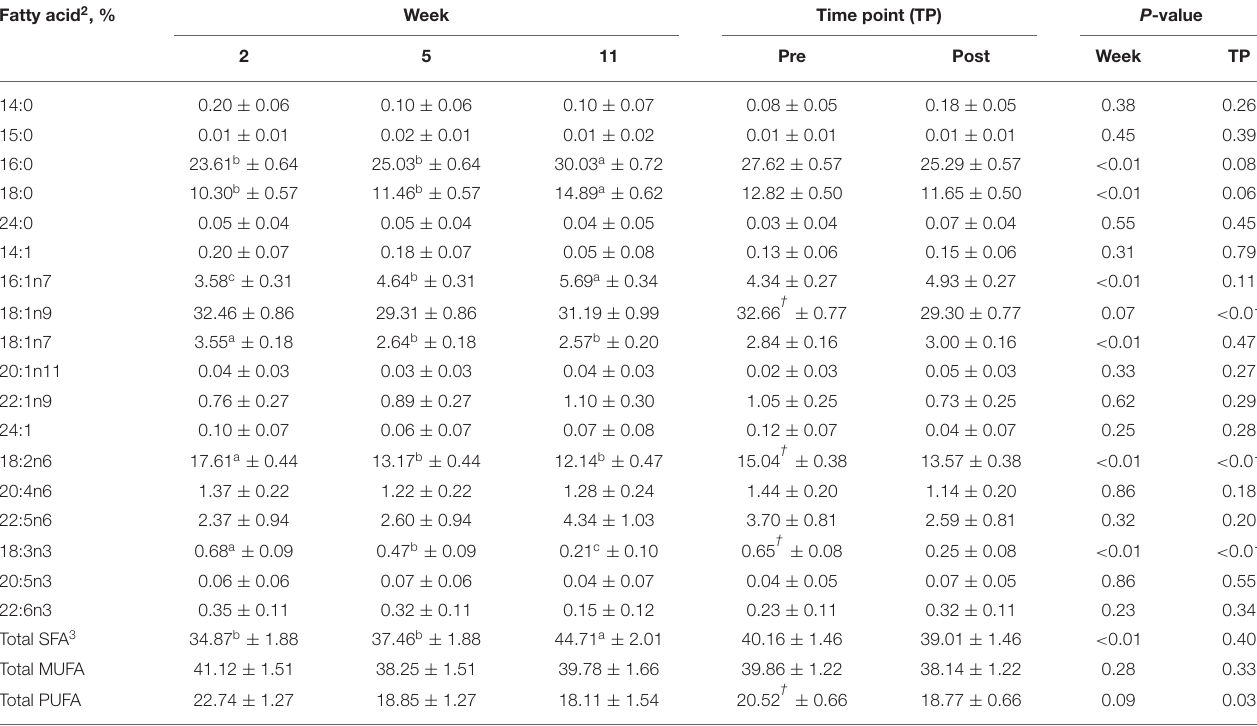
TABLE 4 | Mean fatty acid composition ( ± SE 1 ) and percent contribution of saturated fatty acids (SFA), monounsaturated fatty acids (MUFA), and polyunsaturated fatty acids (PUFA) for the free fatty acid (FFA) fraction identified in serum of all dogs at weeks 2, 5, and 11 (pooled across pre- and post-exercise sampling time points) and at the pre- and post-exercise sampling time points (pooled across weeks 2, 5, and 11). Fatty acid 2 ,